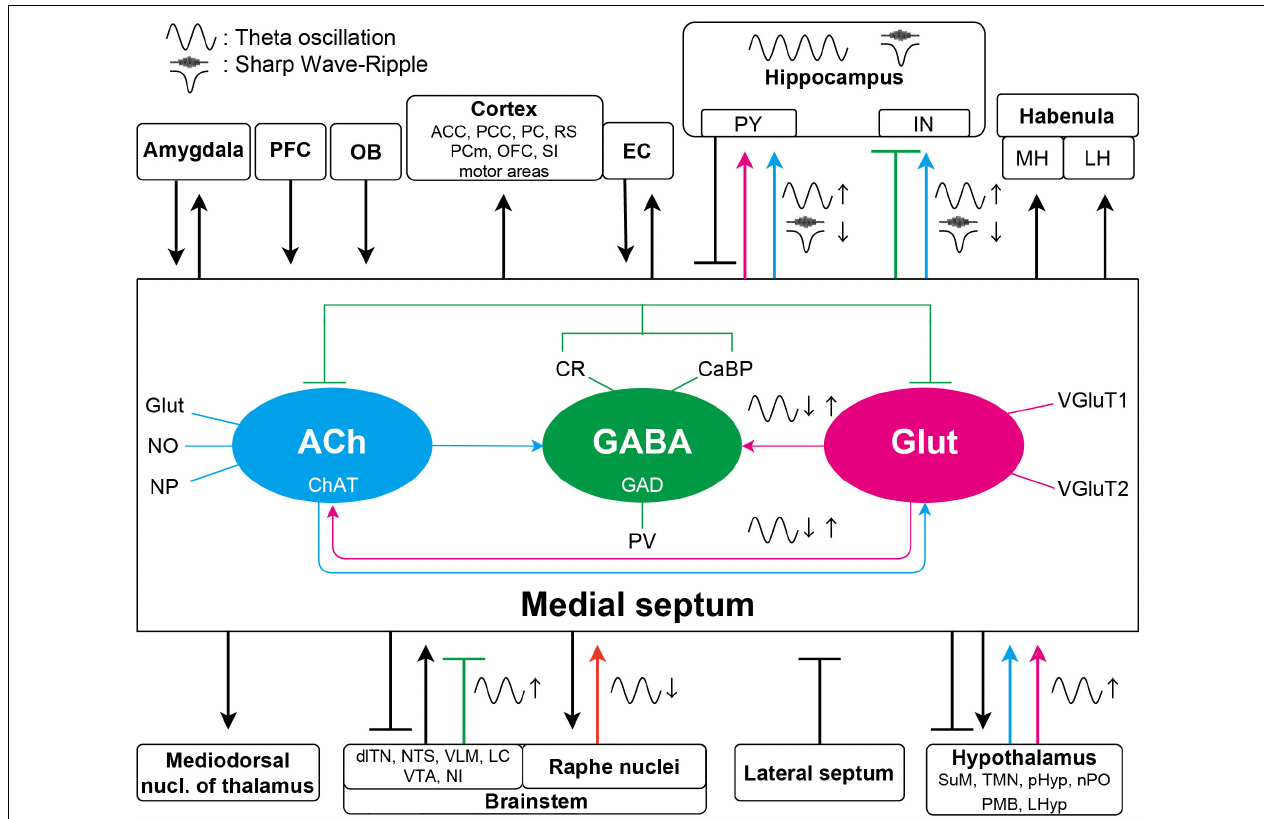
FIGURE 1 | Schematic diagram of the septal connections discussed in this article. The three major neuronal populations maintain a delicate intraseptal network. The medial septal region receives a variety of afferents from the lateral septum, PFC, and forms bidirectional connection with amygdala, EC and a broad range of other neocortical areas, hypothalamus, and brainstem. Unidirectional, overwhelmingly cholinergic efferent fibers are innervating the thalamus and the lateral and medial habenula. For simplicity, specific neurotransmitters and the intraseptal origins or targets of the pathways are only marked in the septohippocampal connections. The medial septum is highly interconnected with the hippocampus as well. These pathways have significant roles in generation or regulation of different hippocampal oscillations. Colored arrows indicate important connections contributing to oscillations in the septo-hippocampal axis. Magenta arrows show glutamatergic, cyan cholinergic, green (blunt) GABAergic, and orange serotonergic innervations. Glutamatergic neurons in the medial septum more likely regulate other theta generating medial septal neuronal populations; however, roles of their projections to the hippocampus in oscillations are largely unknown. The GABAergic neurons have roles in theta generation by disinhibiting the hippocampal pyramidal neurons. The cholinergic connections are not only important in the theta generation, but they also suppress SPW-R generation although whether this suppression acts on the hippocampal pyramidal or interneurons remains elusive. ACC, anterior cingulate cortex; dlTN, dorsolateral tegmental nucleus; EC, entorhinal cortex; IN, interneuron; LC, locus coeruleus; LH, lateral habenula; LHyp, lateral hypothalamus; MH, medial habenula; PCm, medial precentral cortex; NI, nucleus incertus; NTS, nucleus tractus solitarius; OB, olfactory bulb; OFC, orbitofrontal cortex; PCC, posterios cingulate region; PC, piriform cortex; pHyp, posterior hypothalamus; PFC, prefrontal cortex; PMB, posterior mammillary bodies; PY, pyramidal neuron; nPO, nucleus pontis oralis; RS, retrosplenial cortex; SI, substantia innominate; SuM, supramammillary nucleus; TMN, tuberomammillary nucleus; VLM, ventrolateral medulla; VTA, ventral tegmental